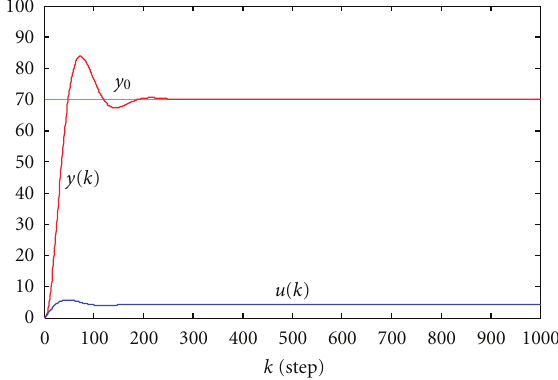
Figure 3: Control result of system